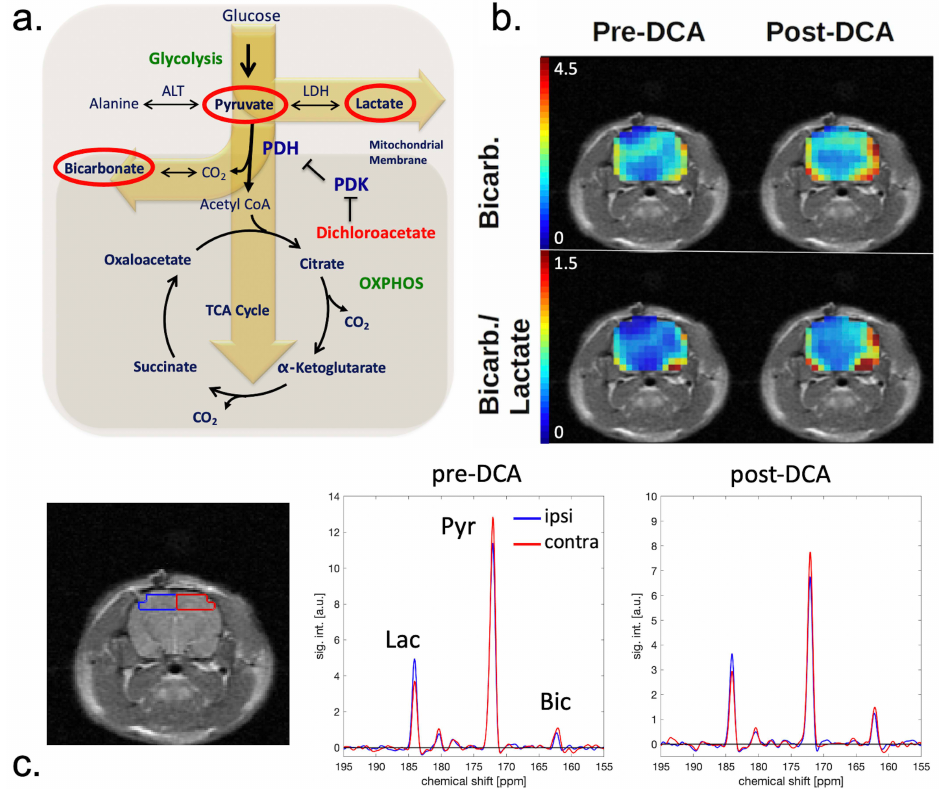
Figure 2. ( a ) Schematic of the tricarboxylic acid cycle. [1- 13 C]pyruvate is converted to [1- 13 C]lactate via lactate dehydrogenase (LDH) and to 13 C-bicarbonate via pyruvate dehydrogenase (PDH). PDH is inhibited by pyruvate dehydrogenase kinase (PDK), which in turn is inhibited by dichloroacetate (DCA). The overall effect of DCA is to increase PDH activity. ( b ) Bicarbonate and bic/lac images of a CCI rat on day 0 before and after DCA administration. The intensity scale is the same for pre- and post-DCA maps. ( c ) Set of corresponding spectra acquired from ROIs in the ipsilateral (blue) and contralateral (red) hemisphere. The location of the ROIs is indicated on the corresponding MRI